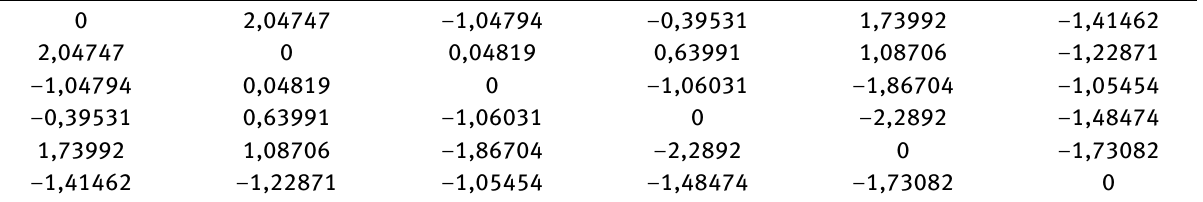
Table 3: Symmetric weight coeflcients of neural network (case